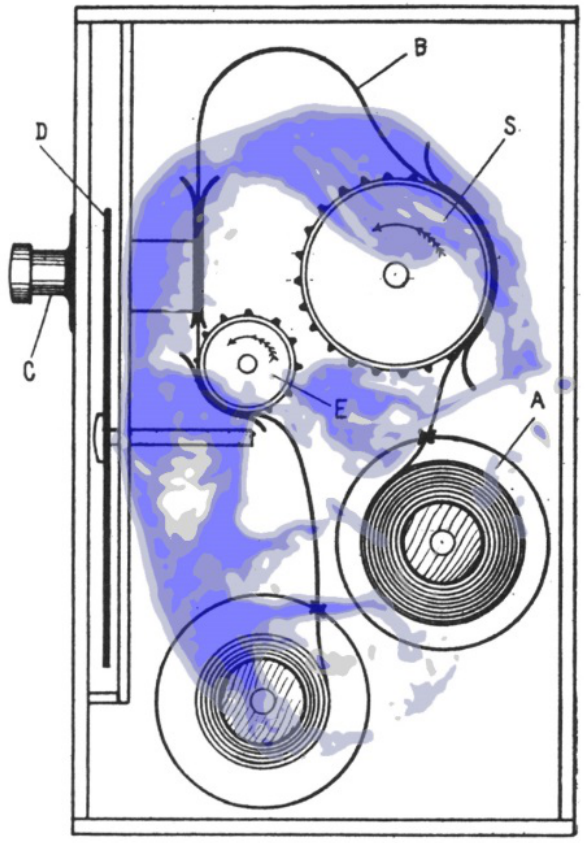
Figure 11. Judd’s kinetoscope . Judd and his movie camera system for recording eye movements. (Portrait adapted from a photograph in Murchison, 1932, and a conventional photo- graphic copy can be found in Wade & Tatler, 2005; kinetoscope from Judd et al,